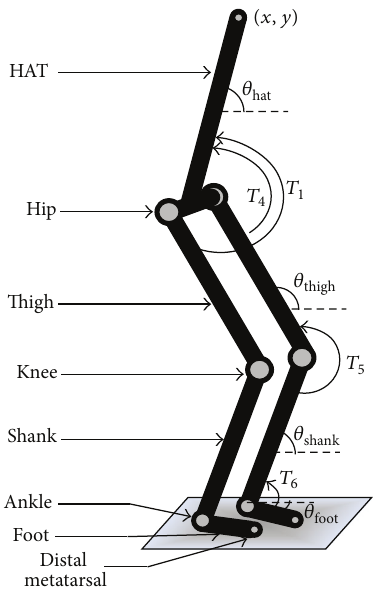
Figure 1: Human body segmentation planar